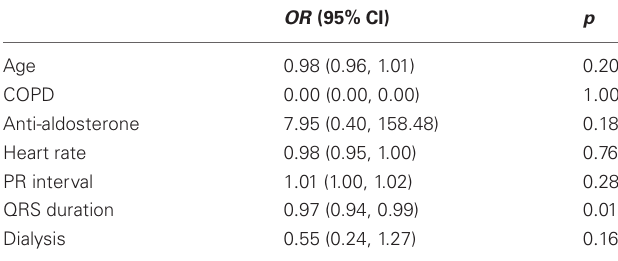
Table 4 | Multivariate logistic regression analyses for the predictors of ER.